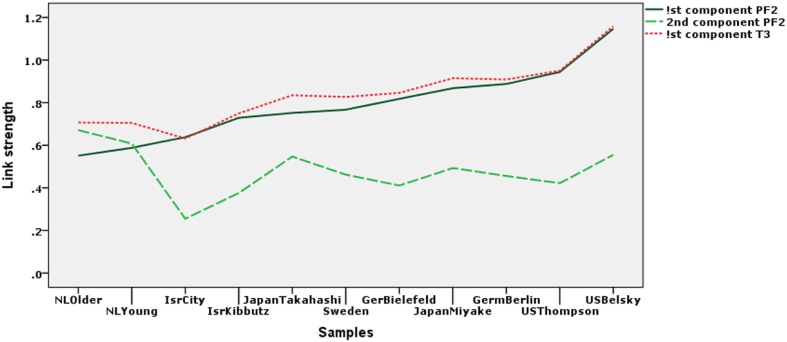
The strength of the Parafac component links (ckss) for each of the samples in principal coordinates. The dotted line represents the weight or strength of the links from the T3221 model (ck) in principal coordinates. For the abbreviations of the samples names see Figure 3.